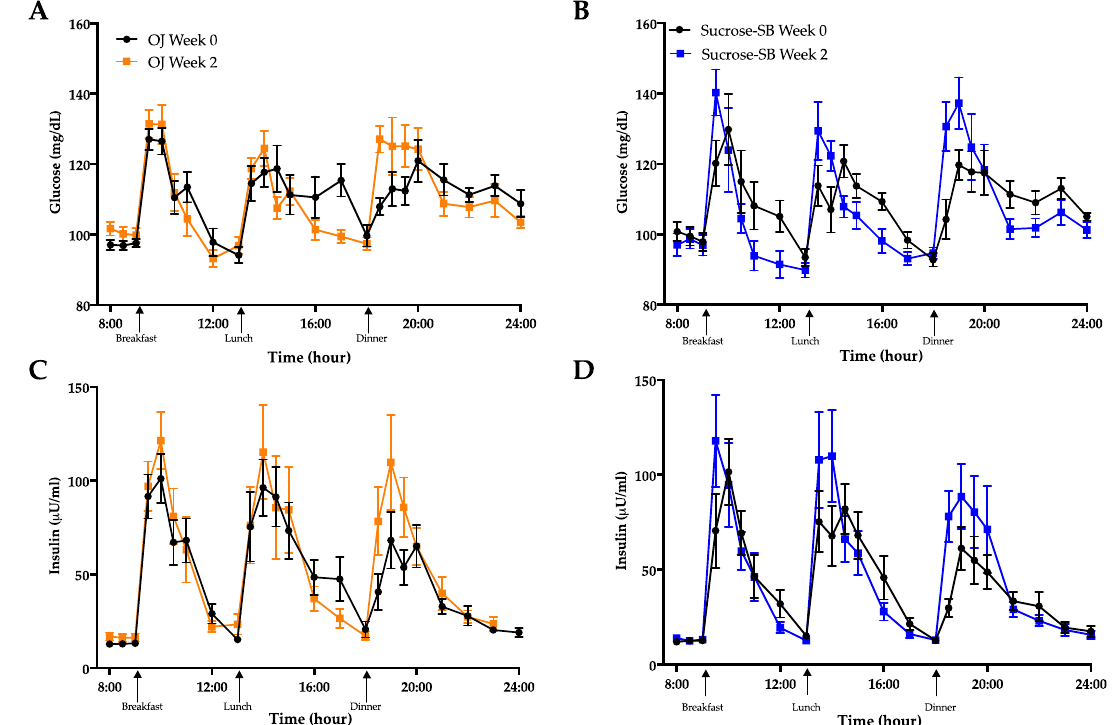
Figure 5. Metrics of insulin sensitivity measured by oral glucose tolerance test (OGTT) and the metabolite, 2-hydroxy- butyrate. Glucose curves during the OGTT before (black line) and after (blue line) consumption of either ( A ) OJ or ( B ) sucrose-SB for two weeks; Insulin curves during the OGTT before (black line) and after (blue line) consumption of either ( C ) OJ or ( D ) sucrose-SB for two weeks; ( E ) Changes in Matsuda Index; ( F ) 2-hydroxybutyrate concentrations measured